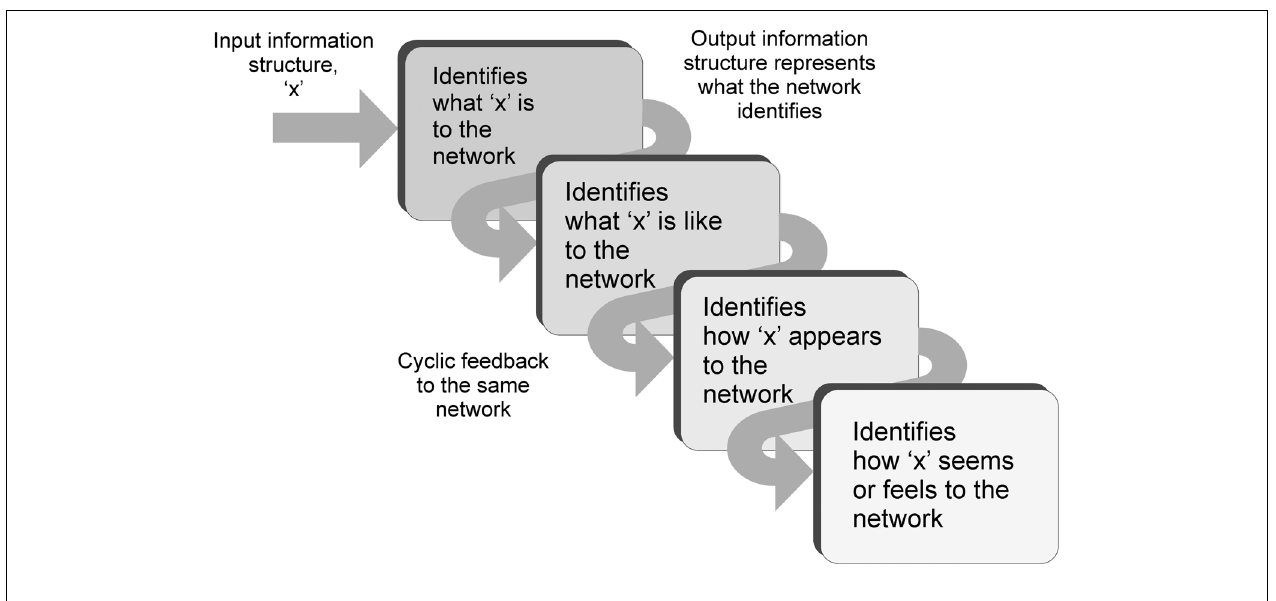
initially recognized as what the input is to the network, but the recognition changes on each pass to become what it is like, to how it appears, to how it